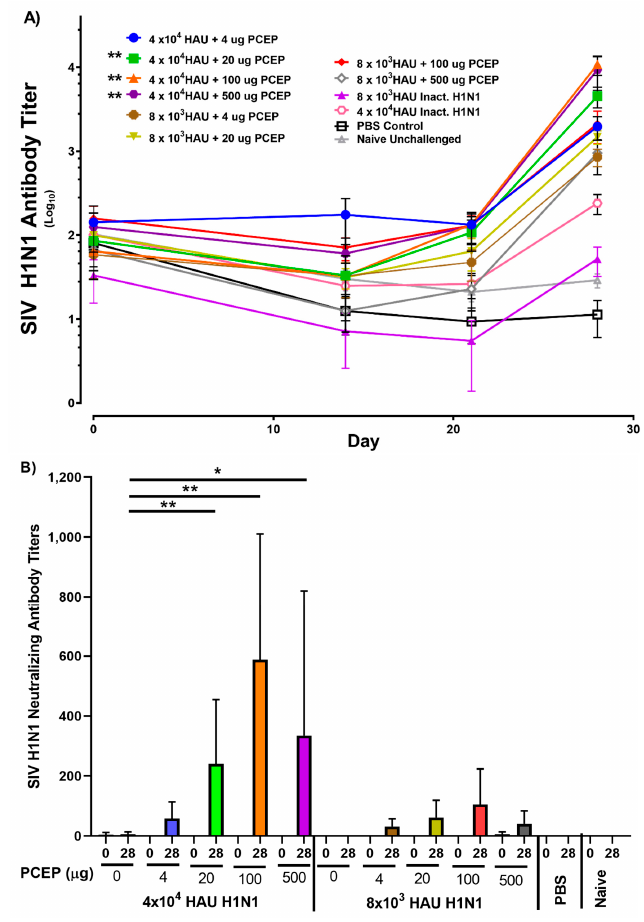
Figure 2. Vaccine-induced H1N1 antibody responses and neutralizing antibody responses in pigs. Pigs ( n = 6 per group) were immunized with 4.0 × 10 4 or 8.0 × 10 3 inactivated SIV HAU alone or plus 4, 20, 100 or 500 μ g PCEP. Control animals were either injected with PBS or not immunized (naïve). A secondary immunization was performed on day 21 and sera samples were collected over a period of 28 days. ( A ) Anti-H1N1 IgG antibodies were assessed by ELISA and ( B ) anti-H1N1 IgG neutralizing antibodies were assessed. Data for animal group are presented with mean values indicated by a horizontal bar and standard error of the mean are shown. p < 0.05 (*), and p < 0.01 (**). Pigs were challenged with 8 × 10 5 PFU virulent SIV H3N2 via the intratracheal route on day 35 using Strain A/swine/Texas/4199-2/1998/H3N2 (Tx98) as previously described by [19]. Challenged and naïve pigs were kept in separate rooms with no direct or indirect contract. Antigen-specific antibody response (Figure 3A,B) and antibody neutralization effect against SIV H1N1 and H3N2 (Figure 3C,D) were assessed up to day 41 post vaccination. All pigs in all groups were euthanized 6- days post-infection and samples were collected.